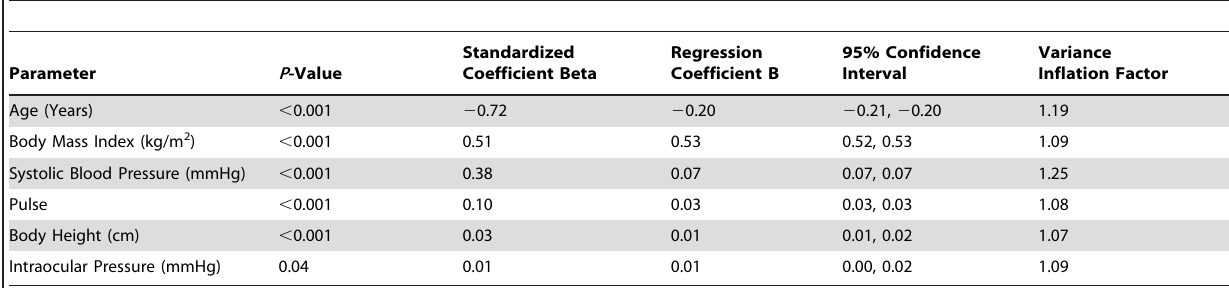
Table 2. Results of the multivariate analysis of the association between the calculated cerebrospinal fluid pressure and systemic and ocular parameters in the non-glaucomatous population of the Central India Eye and Medical Study.